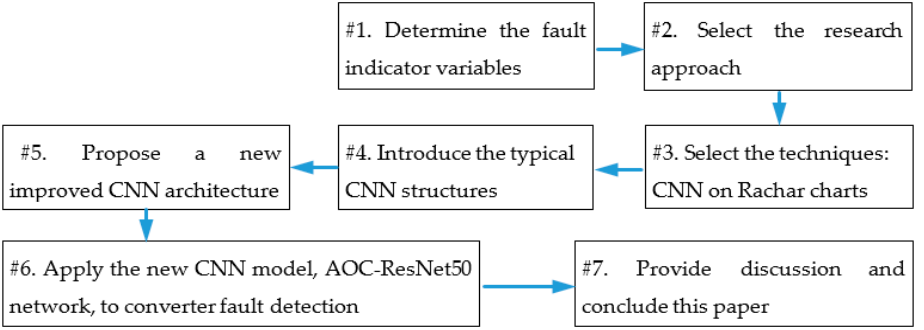
Figure 1. The research workflow diagram.